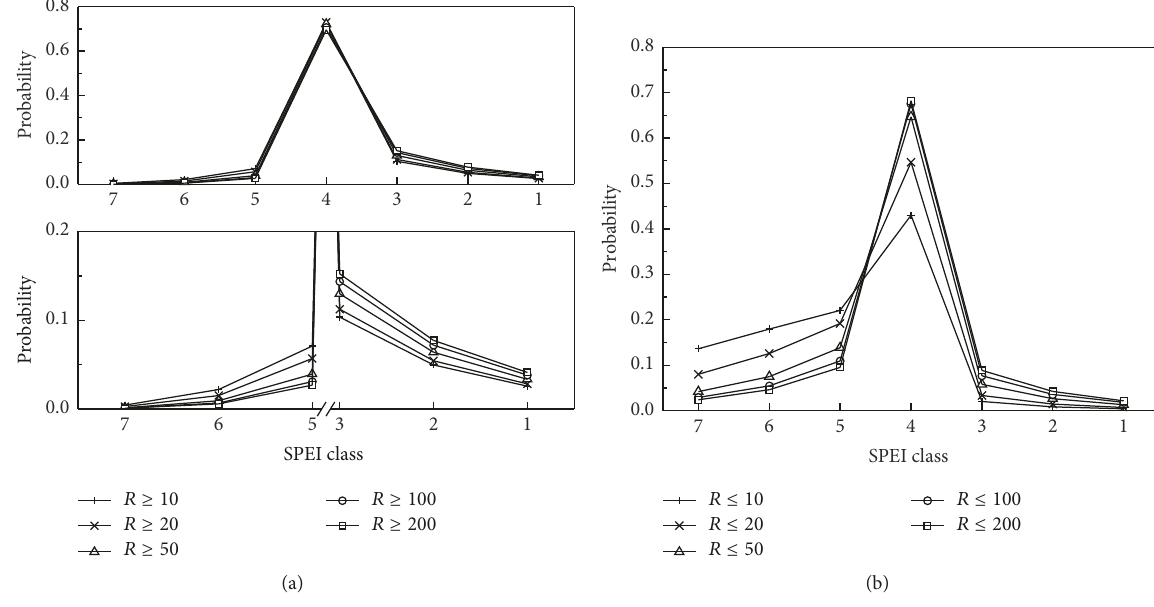
Figure 8: Probabilities of different SPEI classes when (a) 𝑅 ≥ 𝑟 and (b) 𝑅 ≤ 𝑟